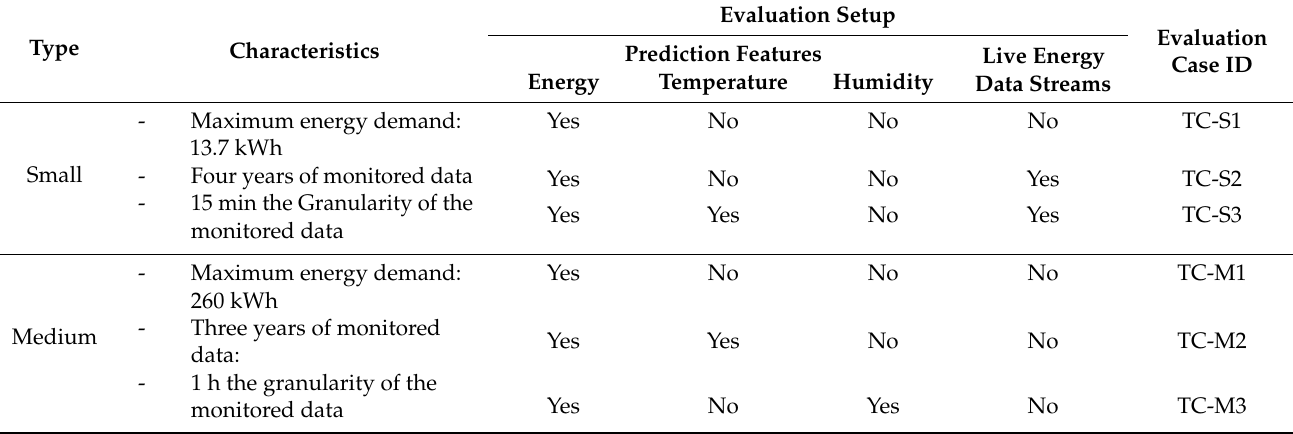
Table 1. Energy-prediction evaluation test cases.